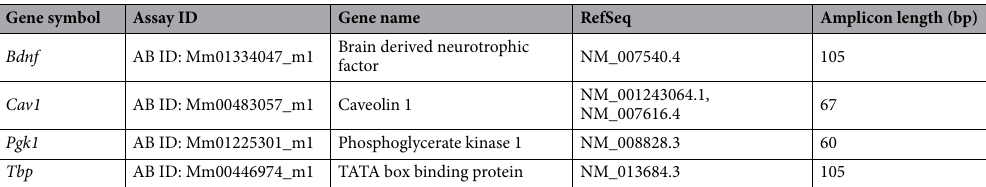
Table 1. The table shows the data on used primers: gene symbols, assay IDs, gene names, GenBank references sequence accession numbers andy amplicon lengths (bp). AB ID applied biosystems TaqMan GENE EXPRESSION ASSAY